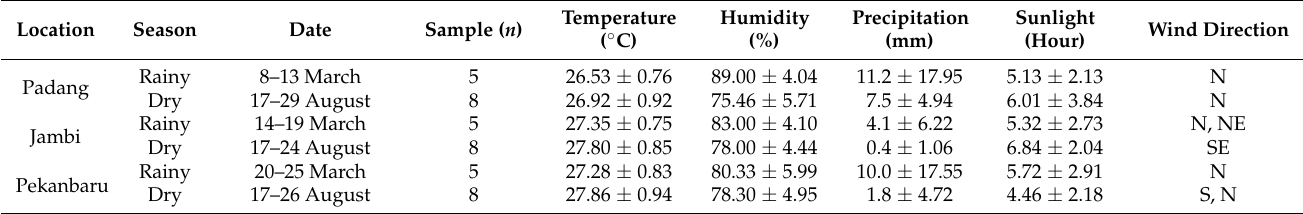
Figure 1. Locations of sampling sites in three different cities on Sumatra island, Indonesia. Table 1. Sampling period, duration, and meteorological conditions in Sumatra island, Indonesia in 2018. Sources: www.bmkg.go.id (accessed on 20 August 2019).